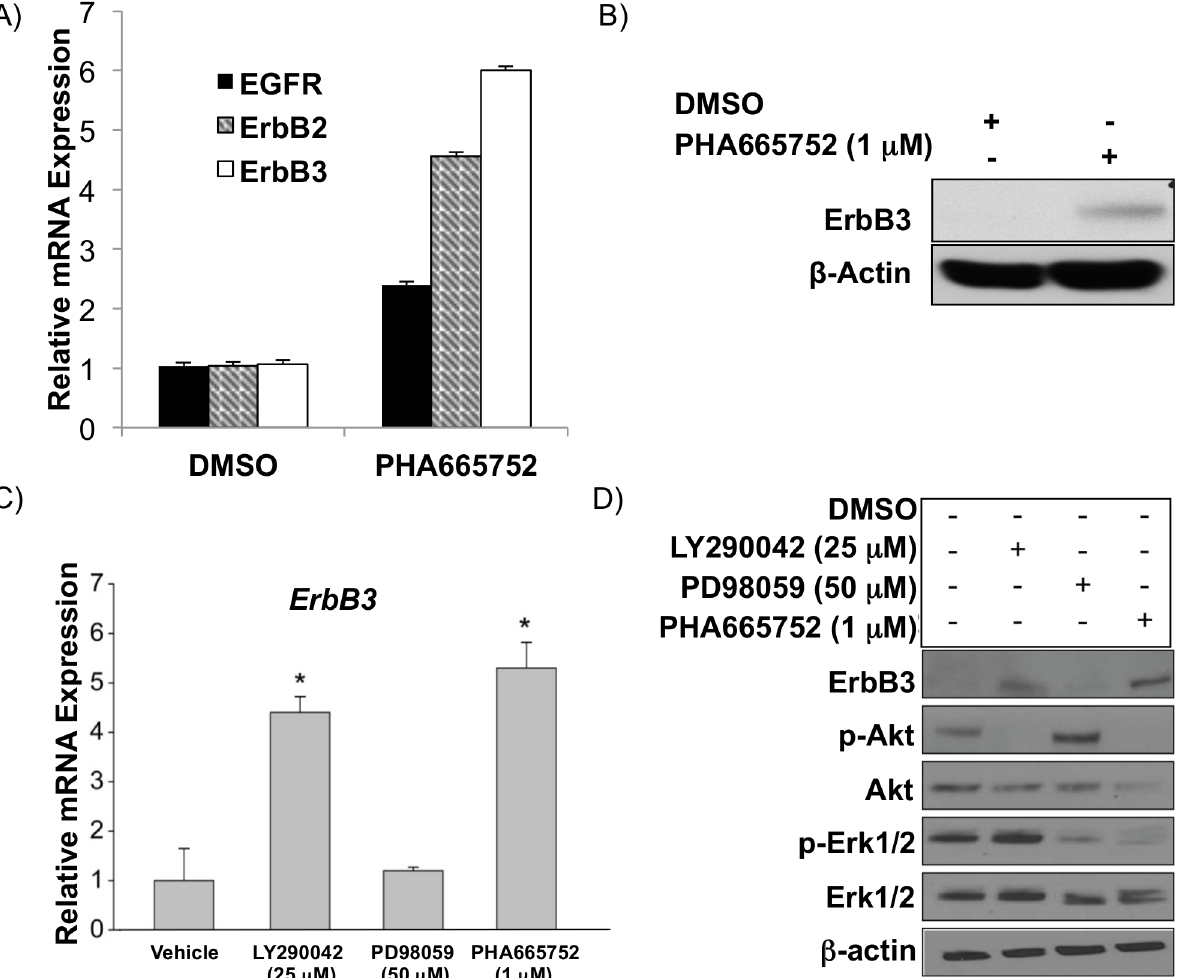
Fig 4. Suppression of c-Met in c-Met + HCC upregulates ErbB3 predominantly through the PI3K/Akt signaling arm. (A) EGFR, ErbB2, and ErbB3 mRNA by qRT-PCR and (B) ErbB3 protein expression by immunoblot in MHCC97-H cells treated with c-Met inhibitor PHA665752 (1 μ M) 48 hours after treatment. (C) ErbB3 mRNA by qRT-PCR and (D) protein by immunoblot in MHCC97-H cells treated with c-Met inhibitor PHA665752 (1 μ M), PI3K inhibitor LY290042 (25 μ M), or Mek inhibitor PD98059 (50 μ M) 48 hours after